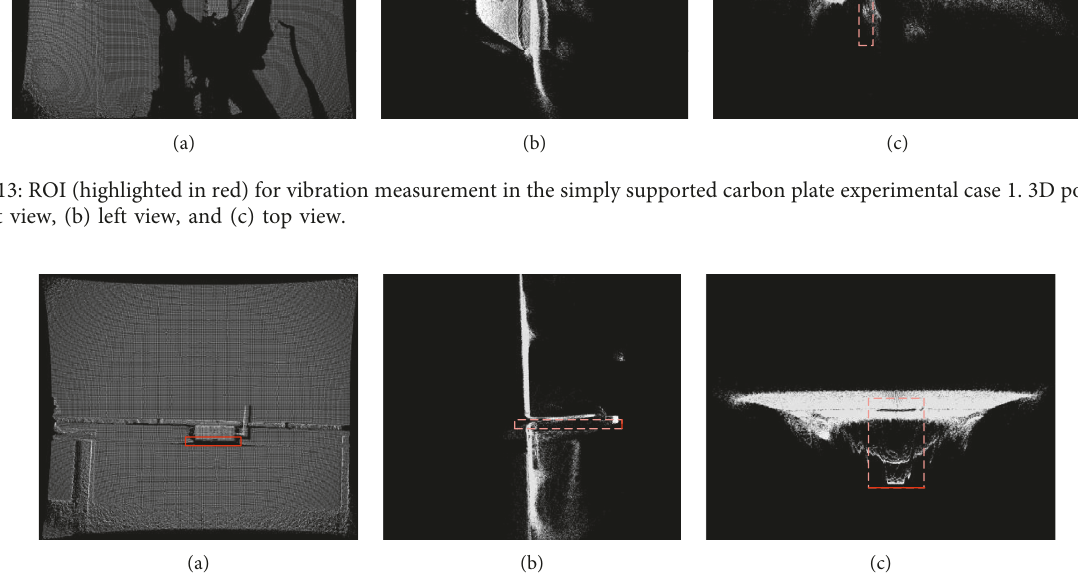
Figure 14: ROI (highlighted in red) for vibration measurement in the simply supported carbon plate experimental case 2. 3D point cloud: (a) front view, (b) left view, and (c) top